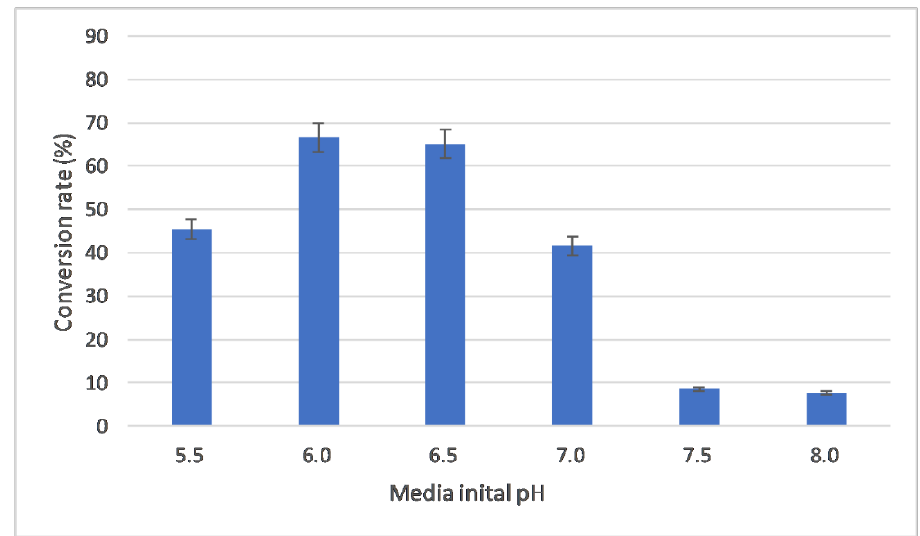
Figure 5. Effects of the initial pH of the media on the metabolite conversion rate (culture time 5 d, media volume 50 mL, inoculation volume 10%, substrate concentration 1 mg/mL).